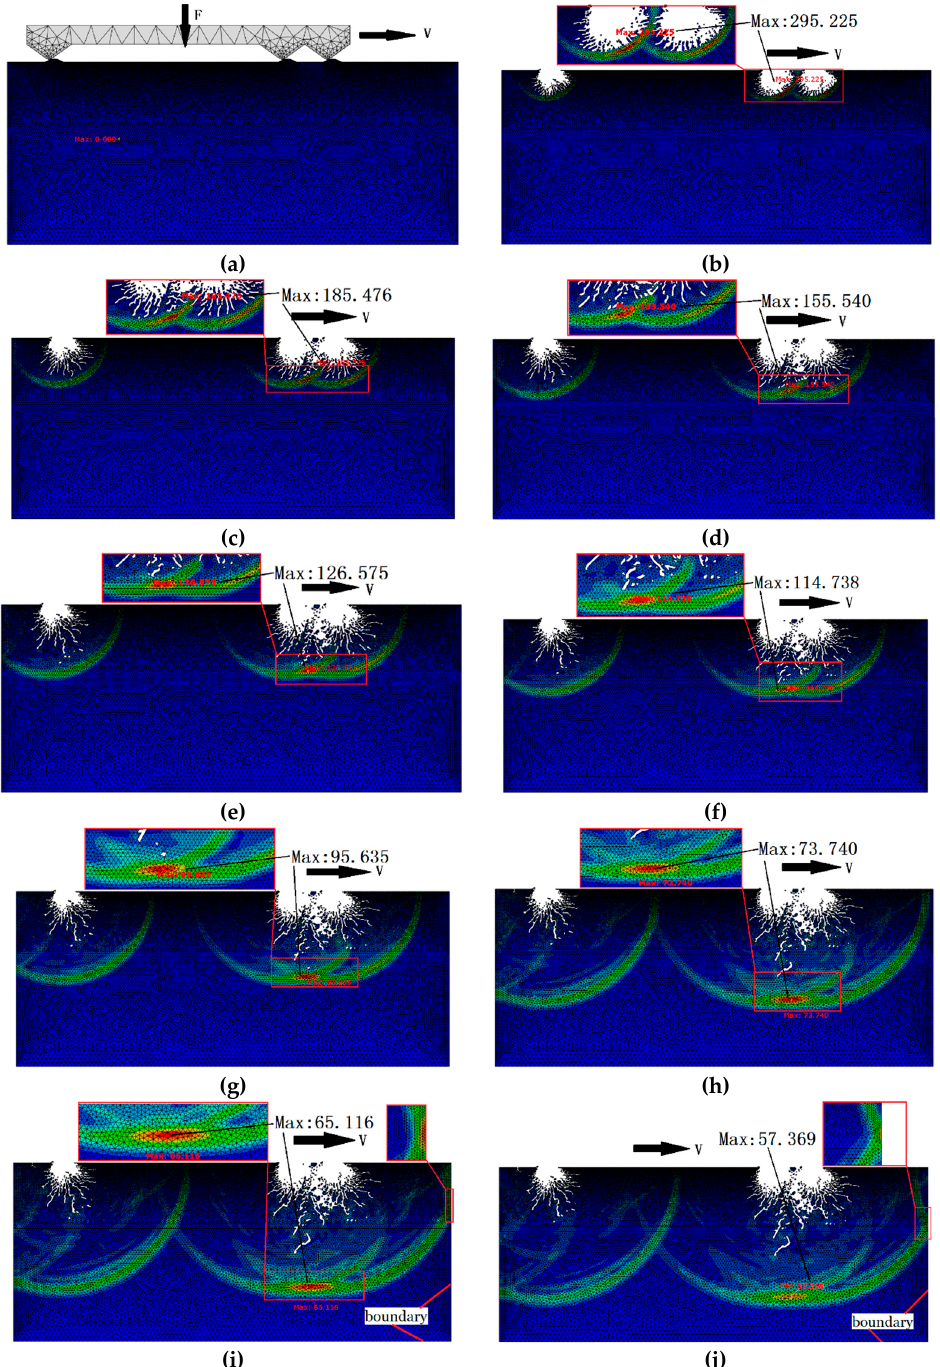
Figure 3. Frictional contact process between abrasive particles and optical glass. ( a ) t = 4.0719 µs; ( b ) t = 19.138 µs; ( c ) t = 27.412 µs; ( d ) t = 32.006 µs; ( e ) t = 37.028 µs; ( f ) t = 41.108 µs; ( g ) t = 48.013 µs; ( h ) t = 59.155 µs; ( i ) t = 65.118 µs; ( j ) t = 69.041 µs.